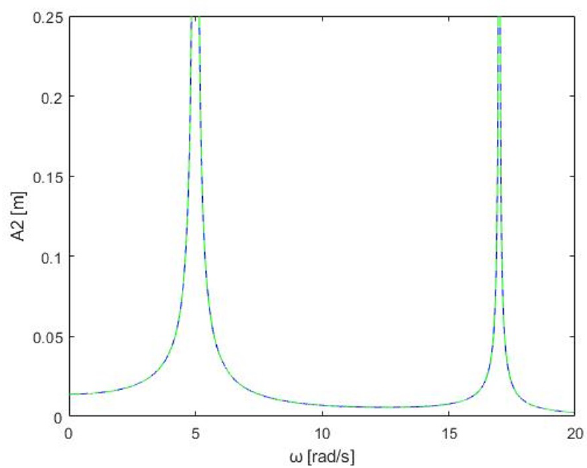
Figure 10. Displacement graph of mass 2 in relation to vibration frequency spectrum (blue plot – structural number calculus; green plot – classical